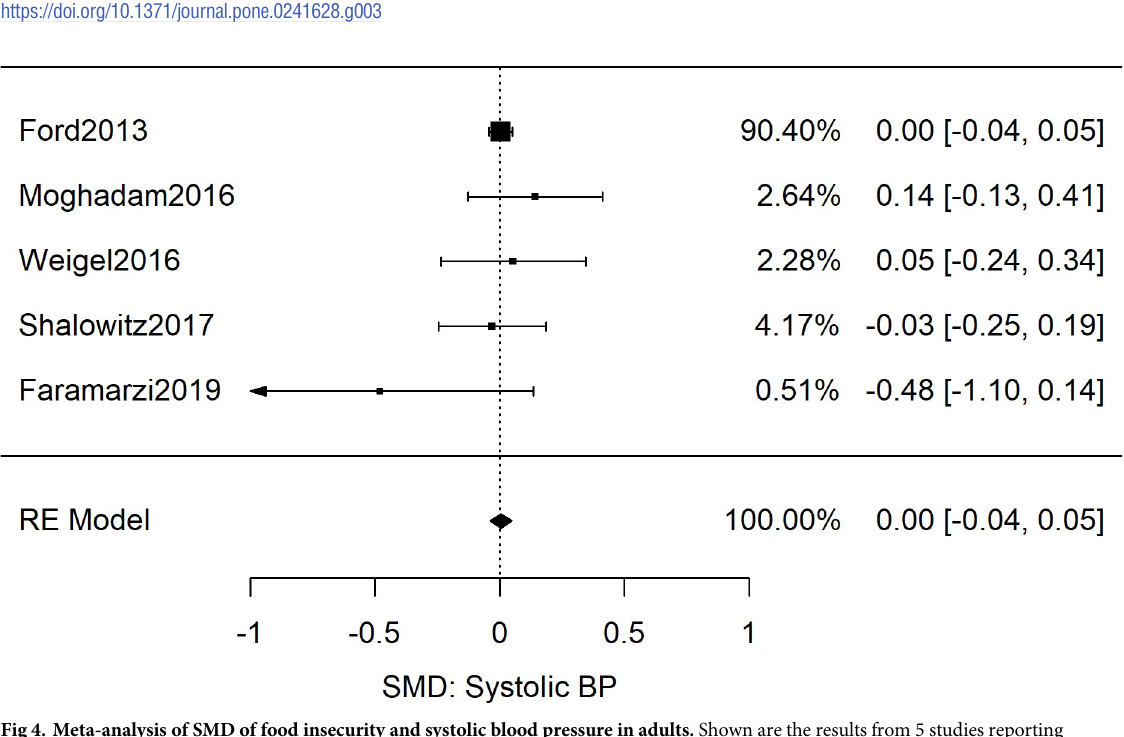
PLOS ONE | https://doi.org/10.1371/journal.pone.0241628 November17,